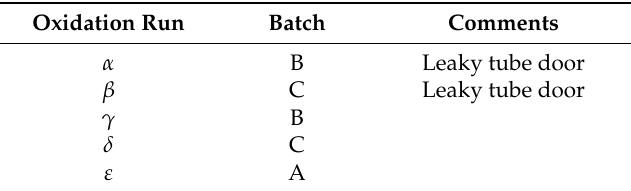
Table 2. Detailed information about the furnace loading.